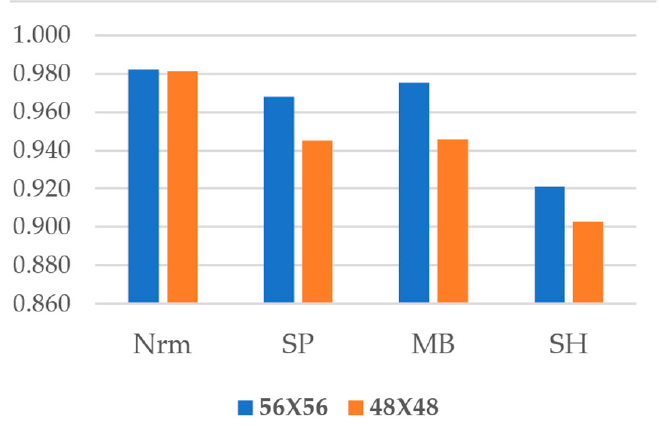
Figure 7. Comparison of Impact of Image Sizes.